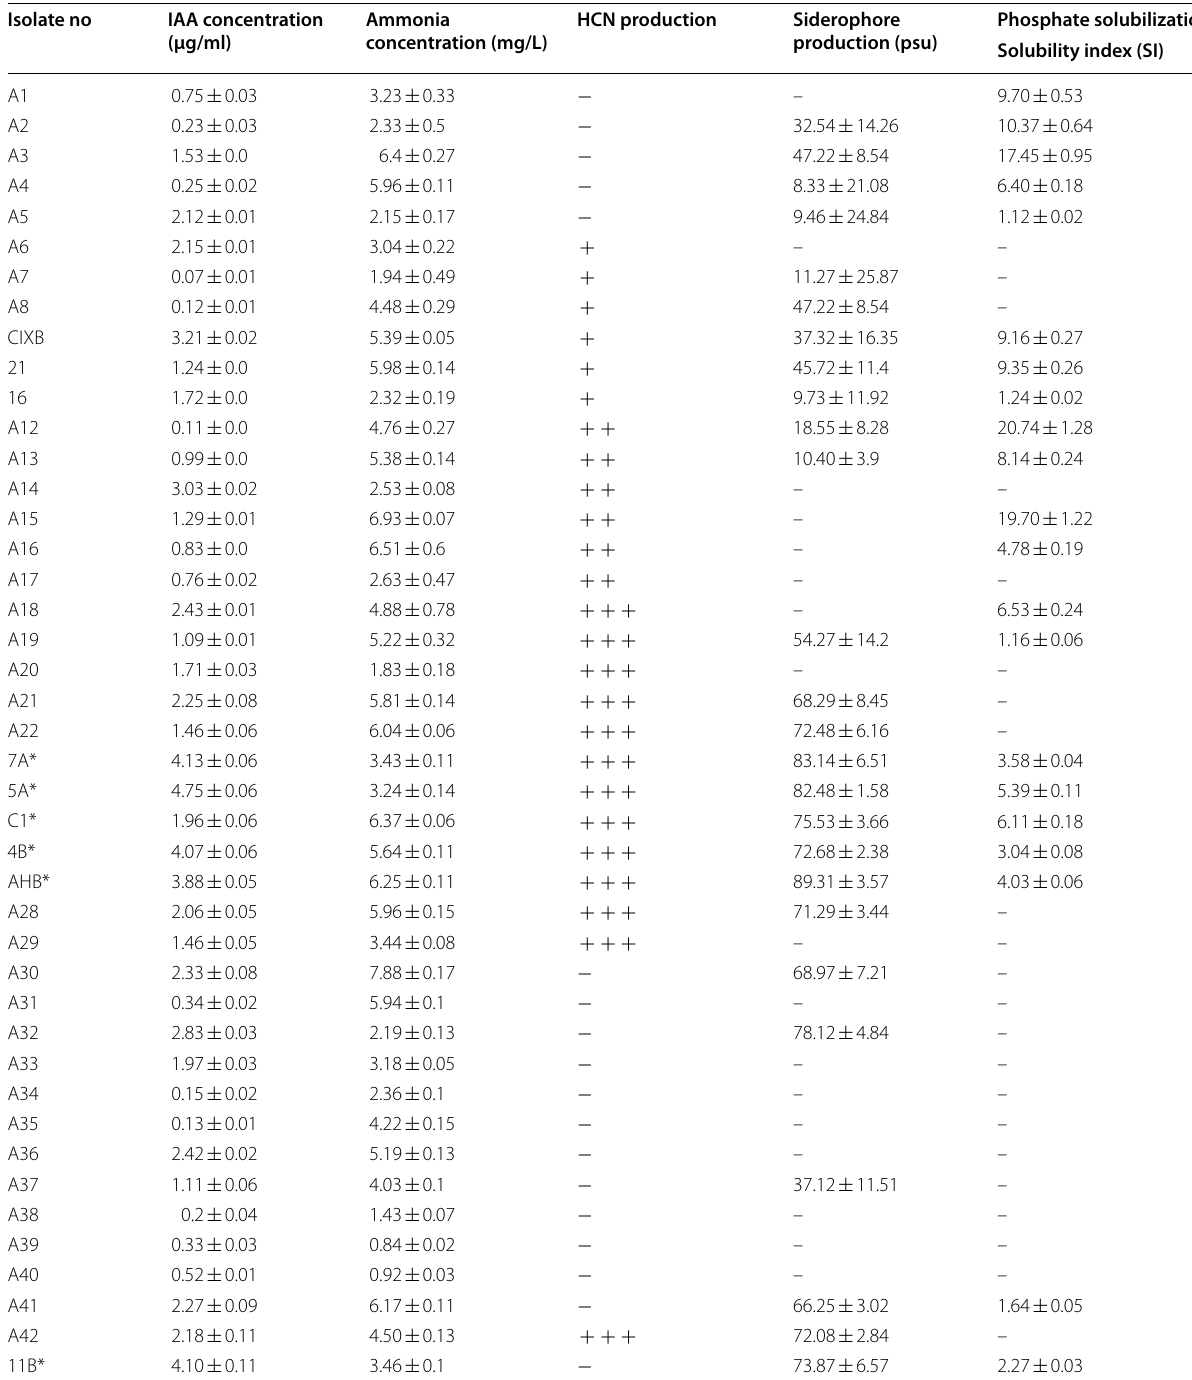
Table 1 Plant growth-promoting activities of λ-cyhalothrin-degrading